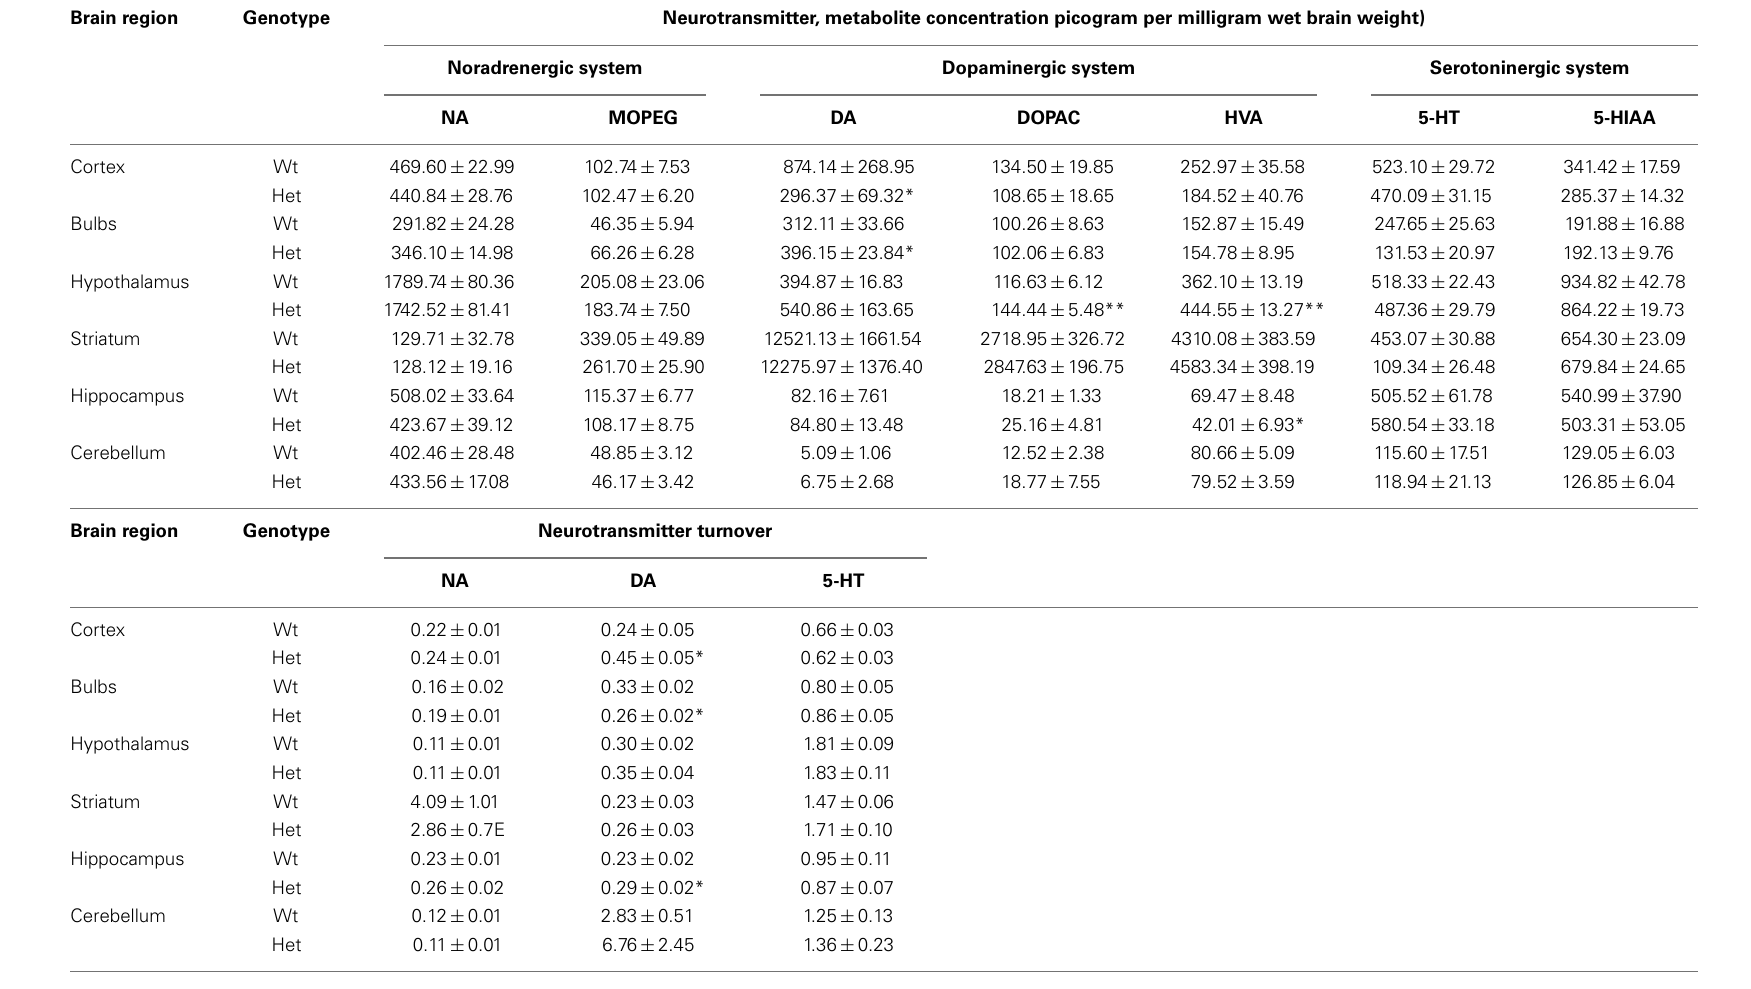
Table 1 | Levels of monoamines and their metabolites detected ex vivo in cortex, bulbs, hypothalamus, striatum, hippocampus, and cerebellum (mean ± SEM: picogram per milligram of wet tissue)